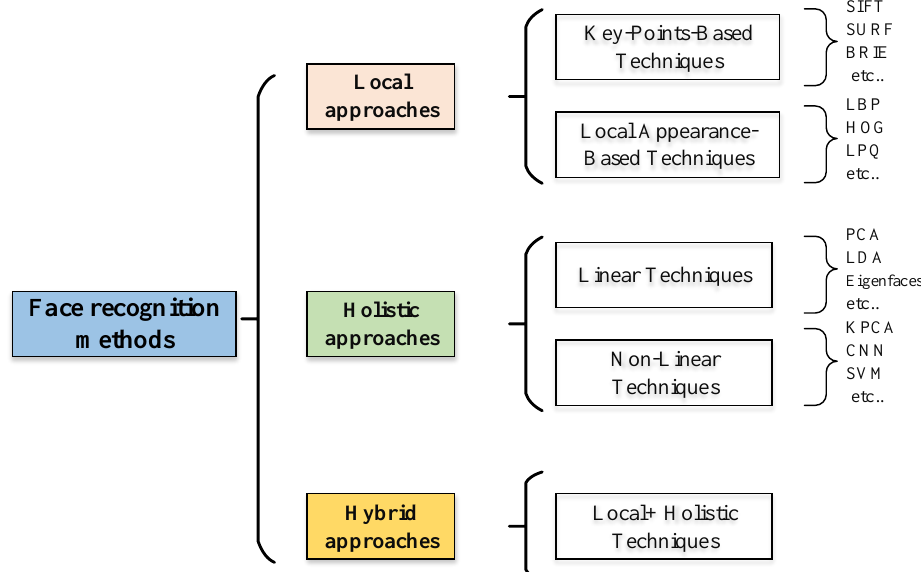
Figure 2. Face recognition methods. SIFT, scale-invariant feature transform; SURF, scale-invariant feature transform; BRIEF, binary robust independent elementary features; LBP, local binary pattern; HOG, histogram of oriented gradients; LPQ, local phase quantization; PCA, principal component analysis; LDA, linear discriminant analysis; KPCA, kernel PCA; CNN, convolutional neural network; SVM, support vector machine.